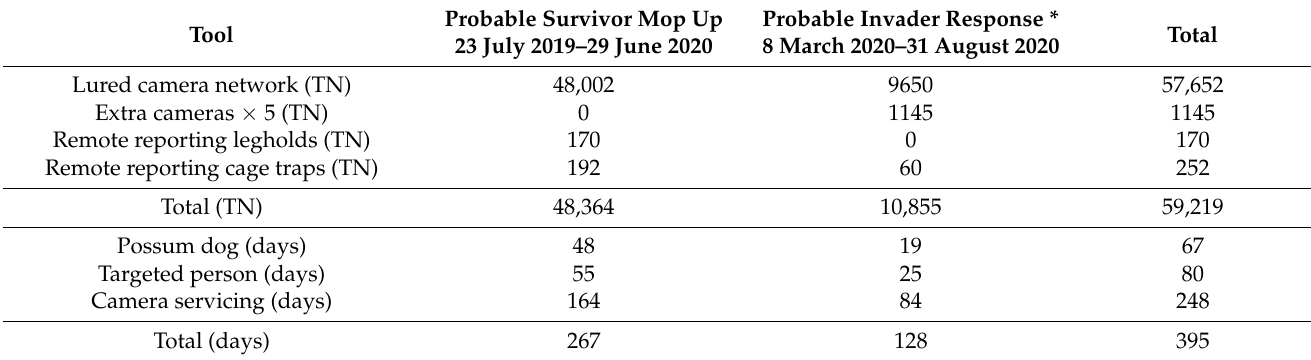
Table 1. Trap nights (TN) and days of effort using detection and response tools for (assumed) surviving and invading possums in the Perth Valley. Probable Survivor Mop Up Probable Invader Response * Tool